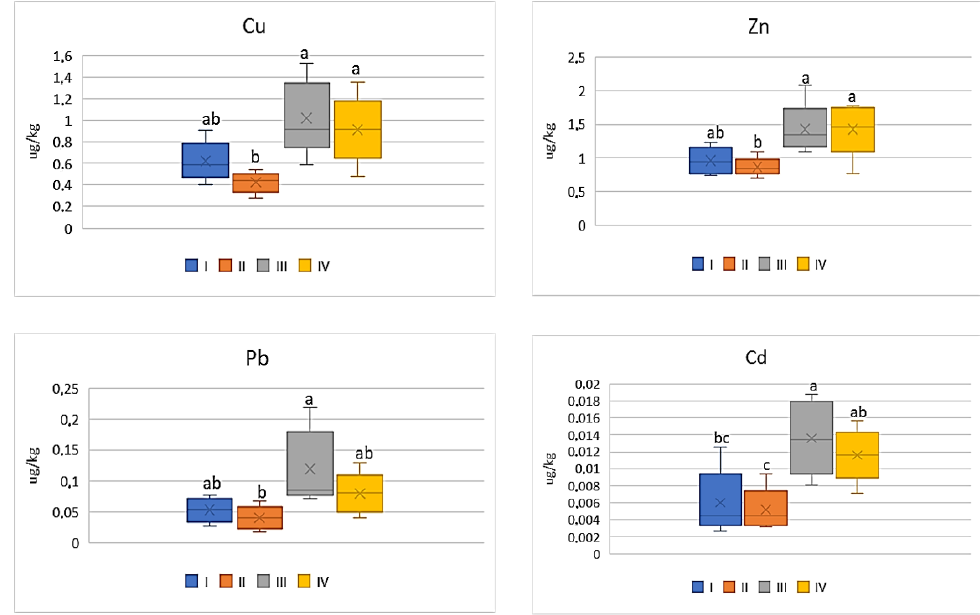
Figure 6. DIM values for carrot depending on the metal and study zones. The same letters mean no significant differences between the values.